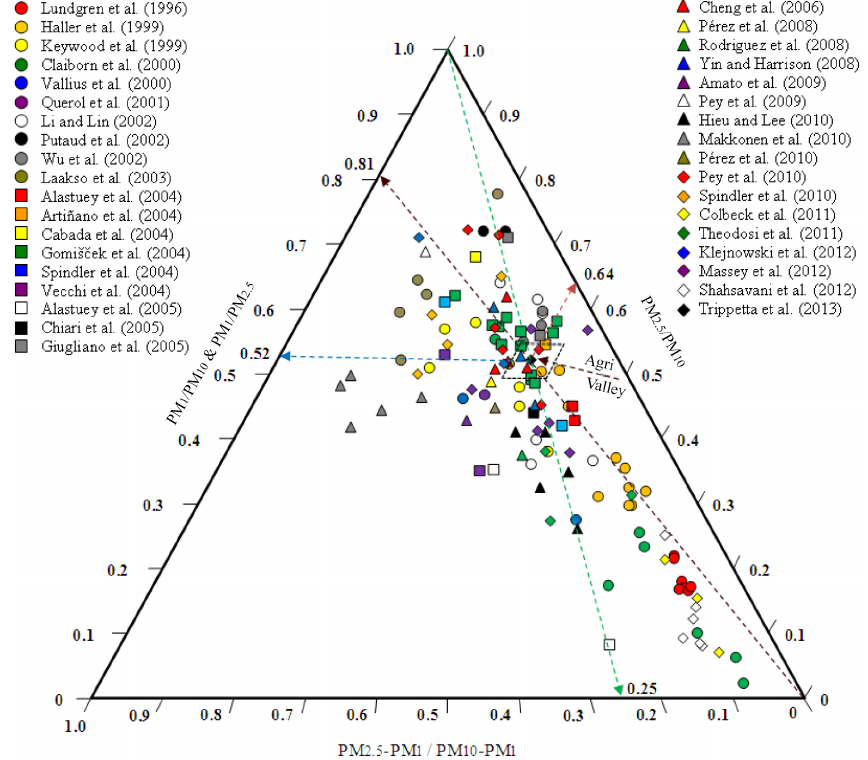
Figure 2. Triangular diagram for the PM 1 / PM 10 , PM 2 . 5 / PM 10 , PM 1 / PM 2 . 5 and (PM 2 . 5 − PM 1 )/ (PM 10 − PM 1 ) concentration ratios.